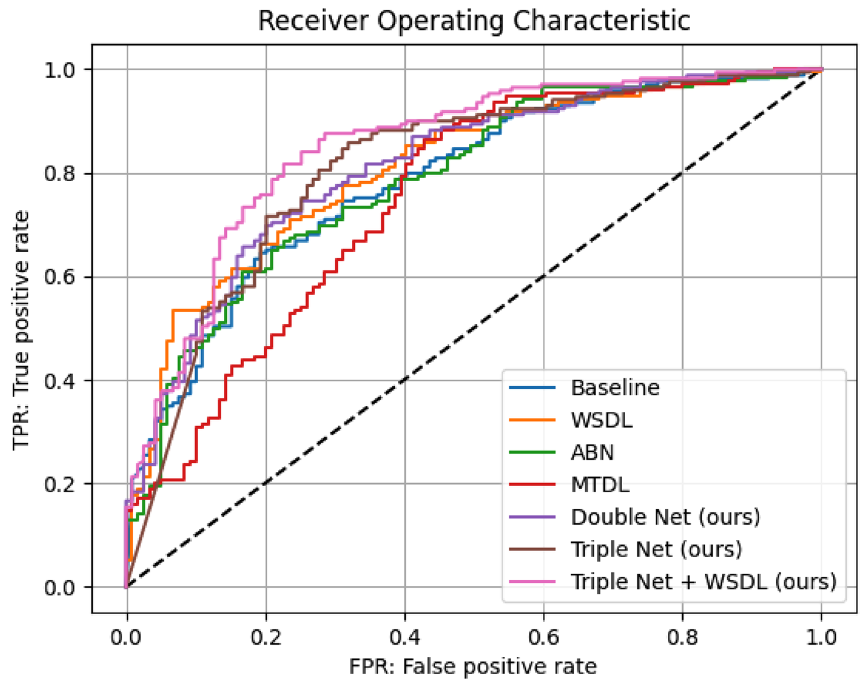
Figure 3. Receiver operating characteristic (ROC) of various methods for binary